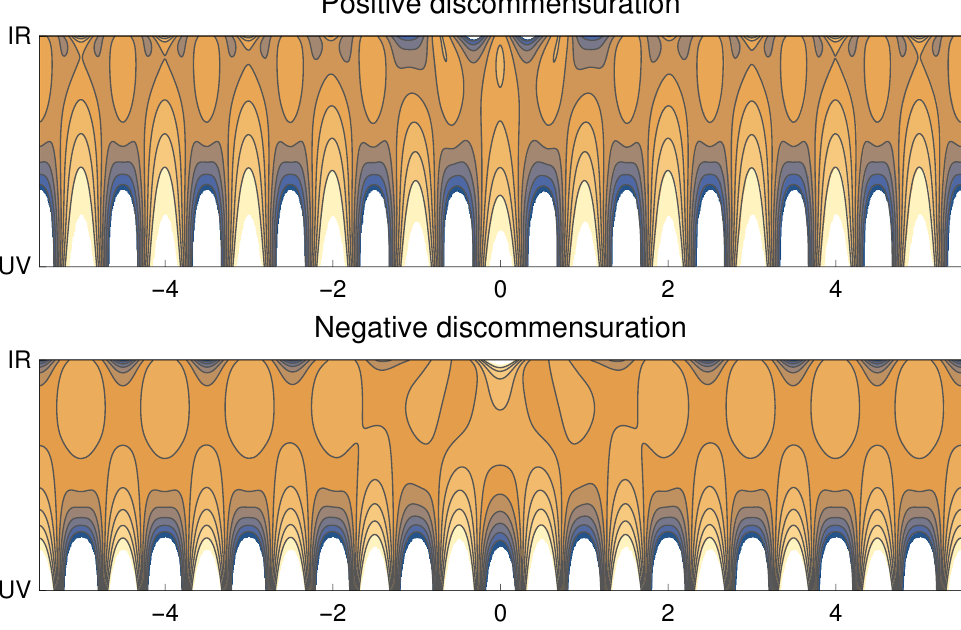
Figure 3 . Bulk pro(cid:12)le of a discommensuration . Shown is the density of electric (cid:12)eld in the bulk @ z A 0 , corresponding to the charge density on UV boundary (bottom). The excess/lack of one period of the spontaneous structure is clearly seen near horizon (top). Outside the core of a